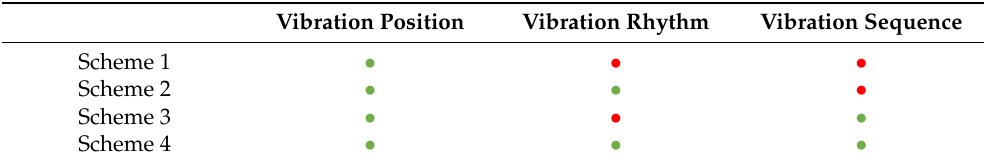
Table 3. Schematic diagram of tactile scheme.